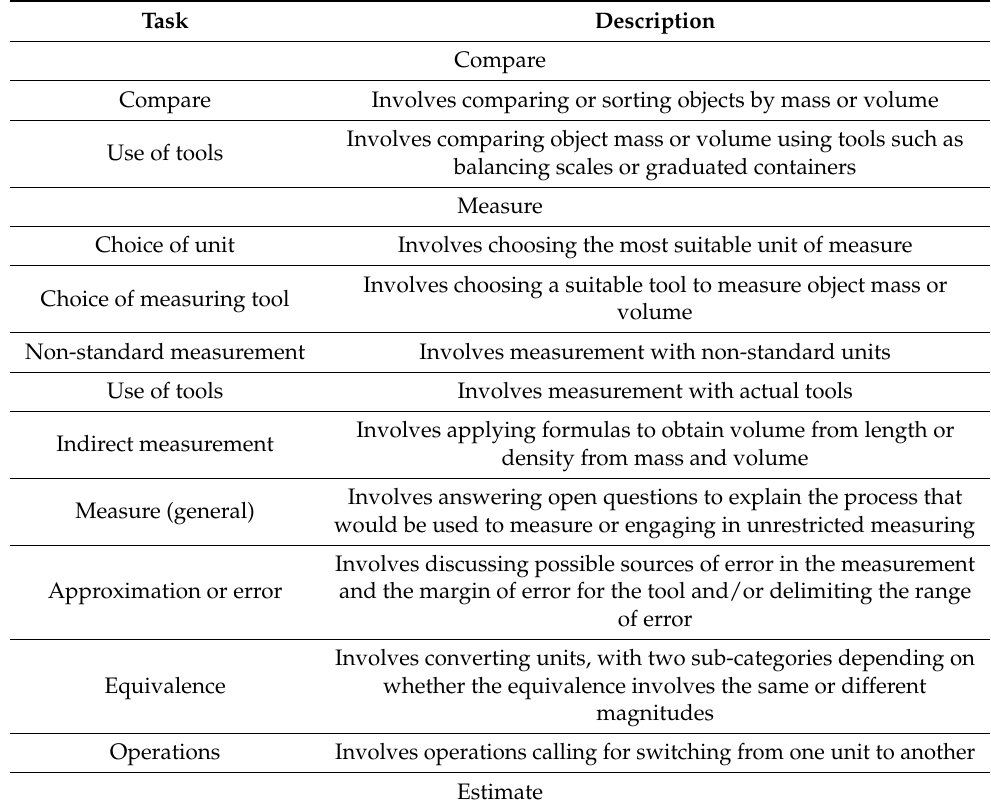
Table 2. Measurement skills addressed in